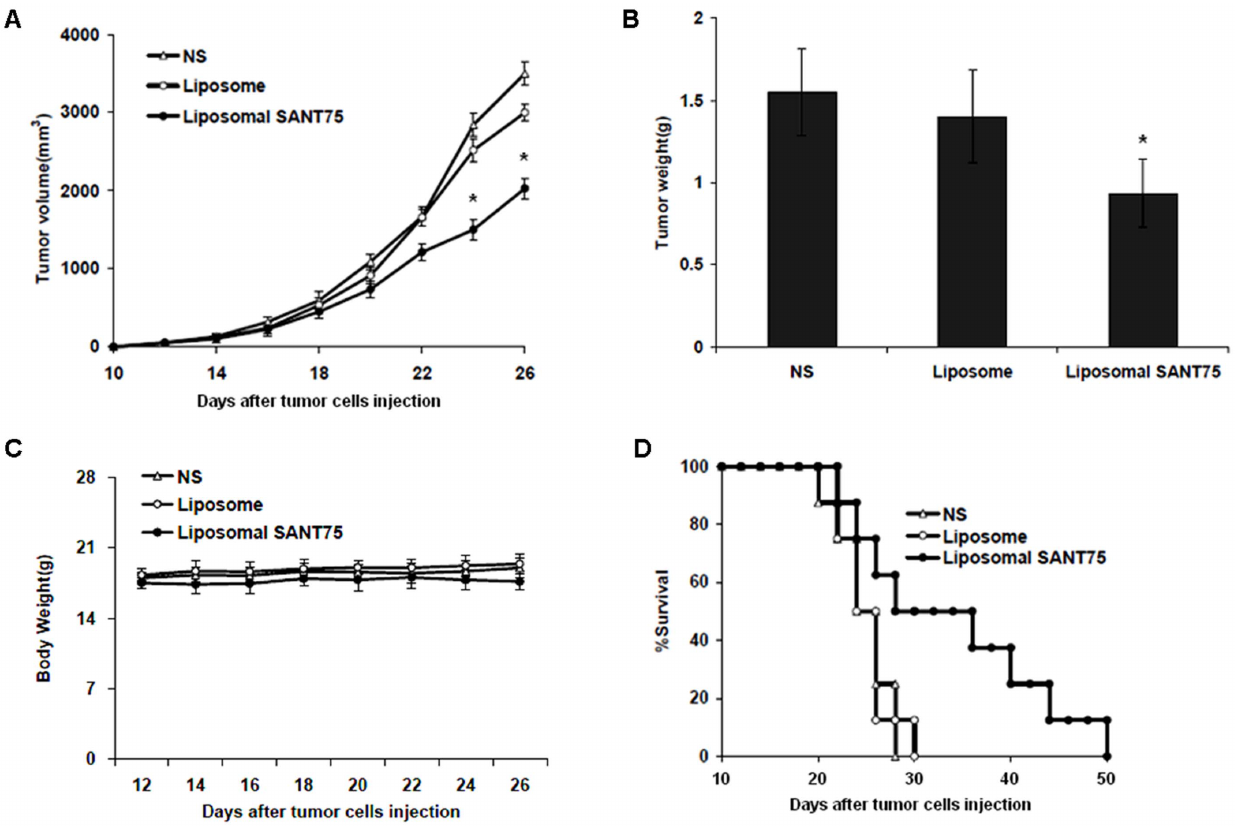
Figure 5. Intravenous administration of liposomal SANT75 inhibited the growth of Lewis lung carcinoma invivo and prolonged the survival of treated mice. (A) Suppression of tumor growth measured by volume in each treatment group. Points, mean; bars, SD. *, P , 0.05, liposomal SANT75 group versus the normal saline or liposome group. (B) Tumor weight of subcutaneously transplanted tumors in each treatment group. Columns, mean; bars, SD. *, P , 0.05, liposomal SANT75 group versus the normal saline or liposome group. (C) The body weight curves of mice in each group. (D) Survival curves of mice in each group.